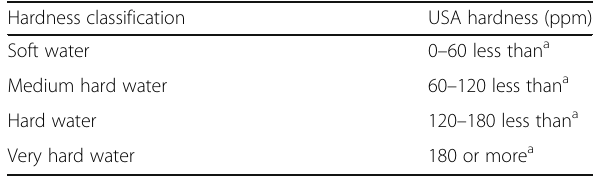
Table 3 Water hardness classification Hardness